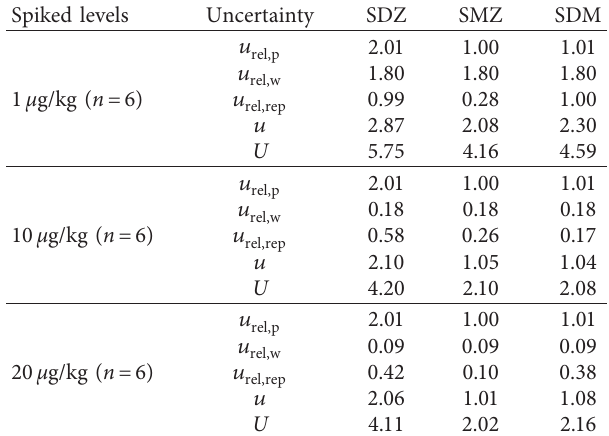
Table 2: Estimated individual uncertainty, relative uncertainty ( u ), and expanded relative uncertainty ( U , k � 2) of three spiked levels (%).